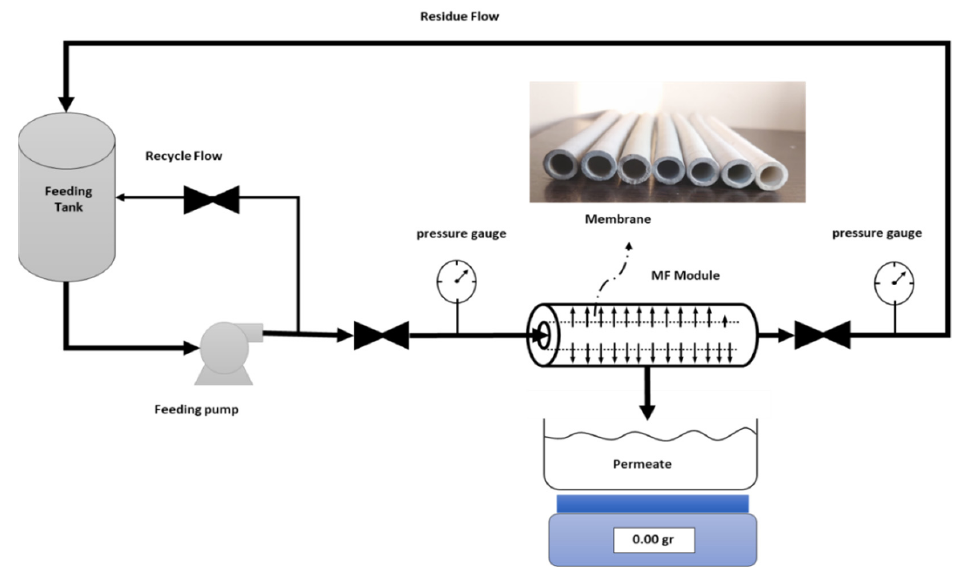
Figure 3. A schematic of the microfiltration system for seawater pre-treatment . Different parameters are involved in a separation process that needs to be measured, such as flux of the membrane and rejection. The flux was measured at a cross flow regime.